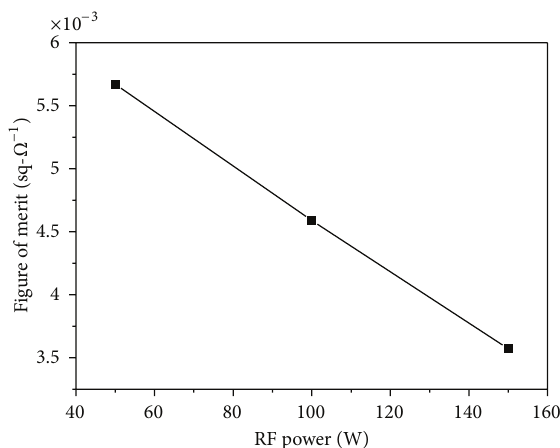
Figure 6: Figure of merit (FOM) of GZO thin films as a function of deposition power.